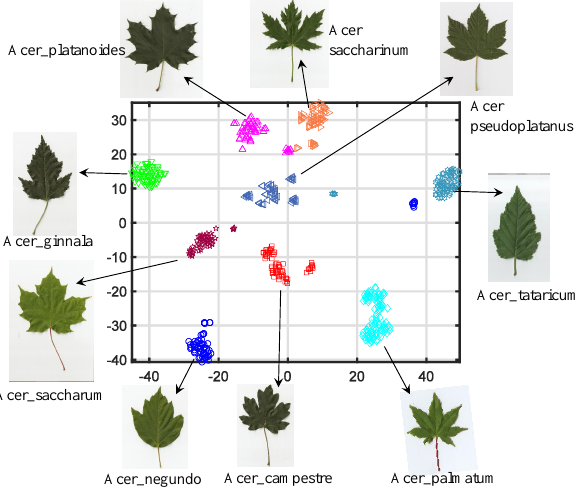
Figure 1. Our learned feature distribution of the 9 species belonging to the same genus Acer from MEW2012 dataset. The t-SNE technology is applied for feature distribution display. Images of the same class are marked with the same color and marker. A total of 600 images are